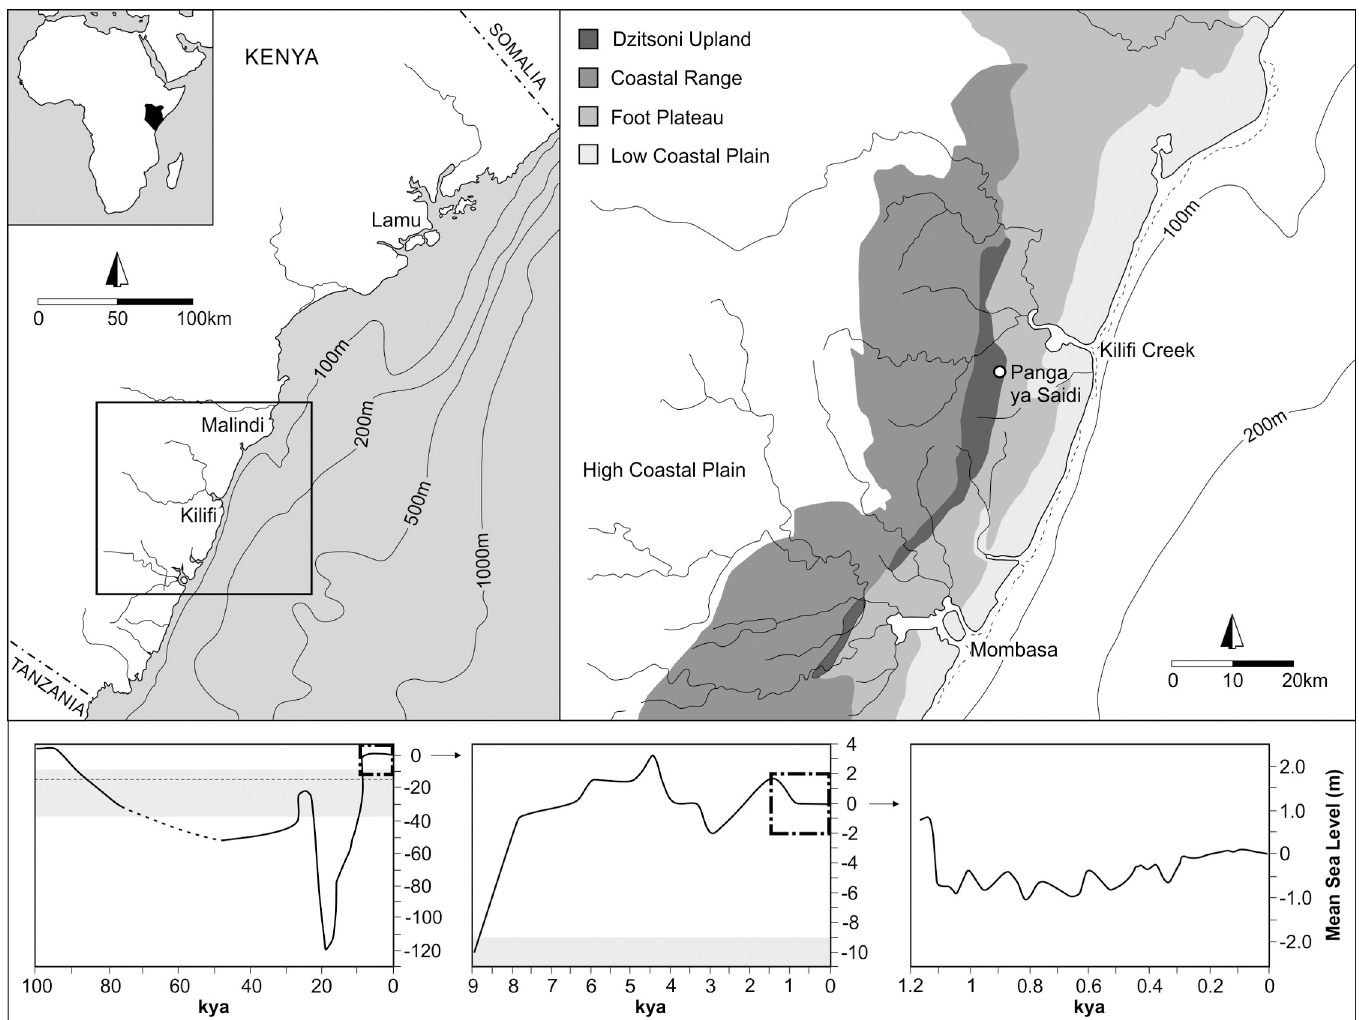
Fig 2. Southern Kenyan coast showing major physiographic divisions, bathymetric data, and mean sea level (MSL). Dashed line in lower left sea level curve at -15 m below MSL represents mean depth of the Kilifi Creek channel. Grey shading in lower left and centre sea level curves indicates the maximum depth at the channel mouth (-38 m) and maximum channel depth at the entrance to Kilifi Creek Lagoon (-9